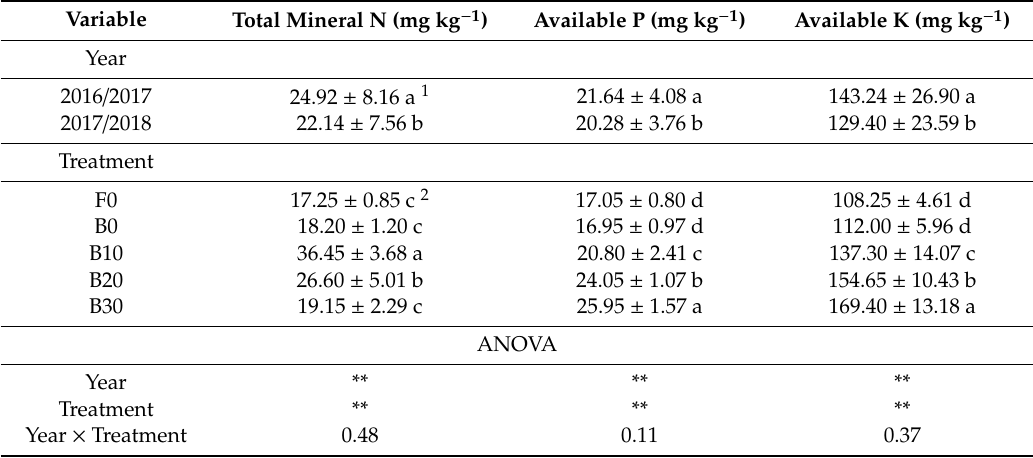
Figure 1. Interaction effect of year and treatment on topsoil (0–20 cm) electrical conductivity. Values are average of four replications. Bars with different letters significantly different at 0.05. F0: freshwater irrigation. B0, B10, B20, B30: saline water irrigation combined with biochar application of 0, 10, 20, 30 t ha − 1 . Table 4. Main e ff ects of year and treatment on topsoil (0–20 cm) total mineral N, available P, available K